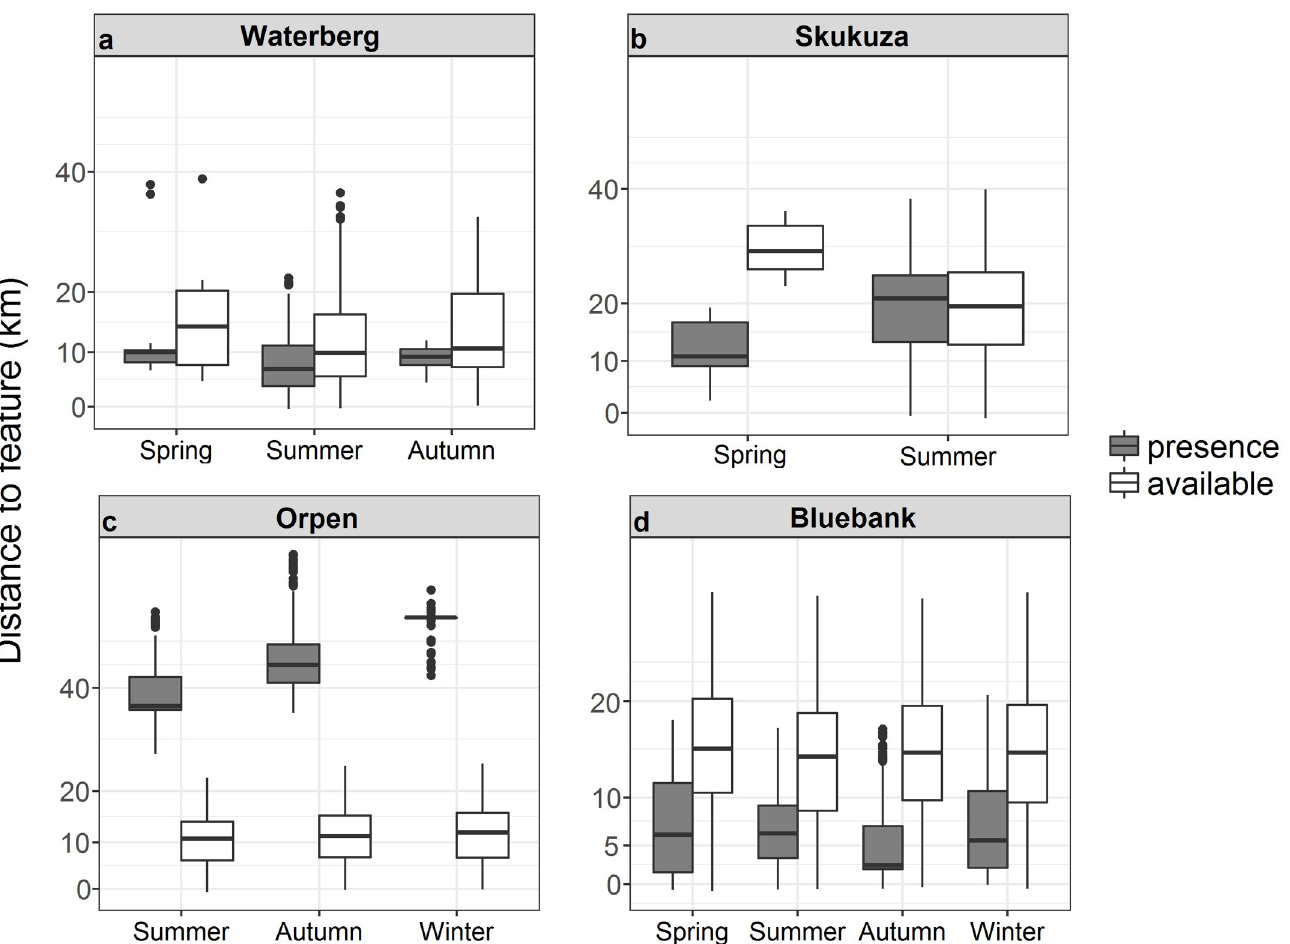
Fig 4. African wild dog pack presence and availability data in areas of agricultural landscape feature types for the a) Waterberg, b) Skukuza, c) Orpen and d) Bluebank packs across different seasons in the Limpopo and Mpumalanga Provinces, South Africa. Boxplots show medians (dark horizontal bars), 1 st and 3 rd interquartiles (boxes), 95% CI (whiskers) and outliers (dots). Presence data are indicated by coloured boxes.